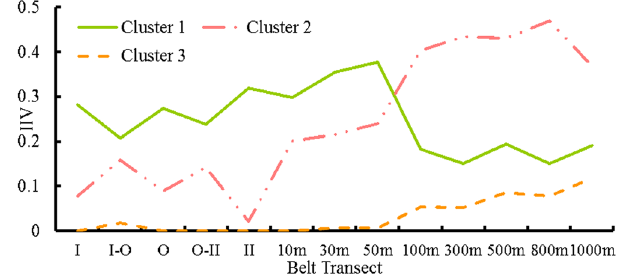
Figure 2. Changes in IIVs of the three clusters in the belt transects in Study Area S1.